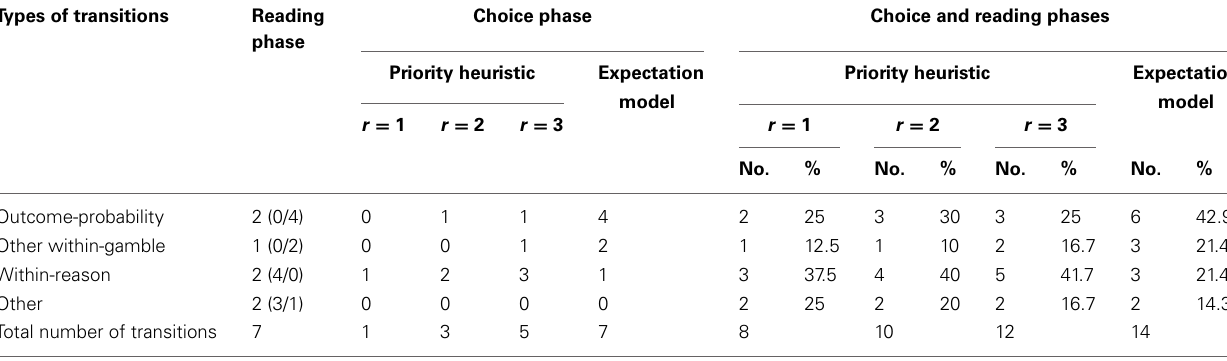
Table B1 | Derivation of the predicted transitions based on alternative assumptions for the reading